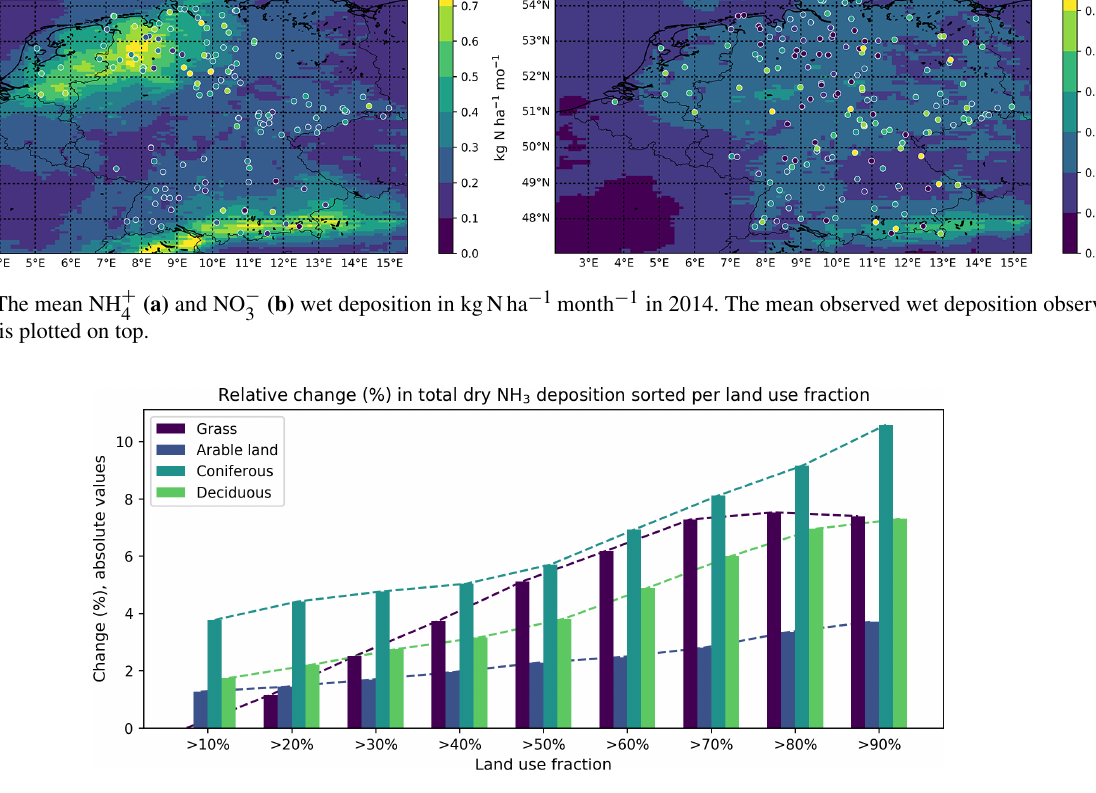
Figure 17. The relative difference (%) in total dry NH 3 deposition in 2014 between the default run (LE default ) and the run with the updated z 0 values (LE z 0 ), sorted by increasing land use